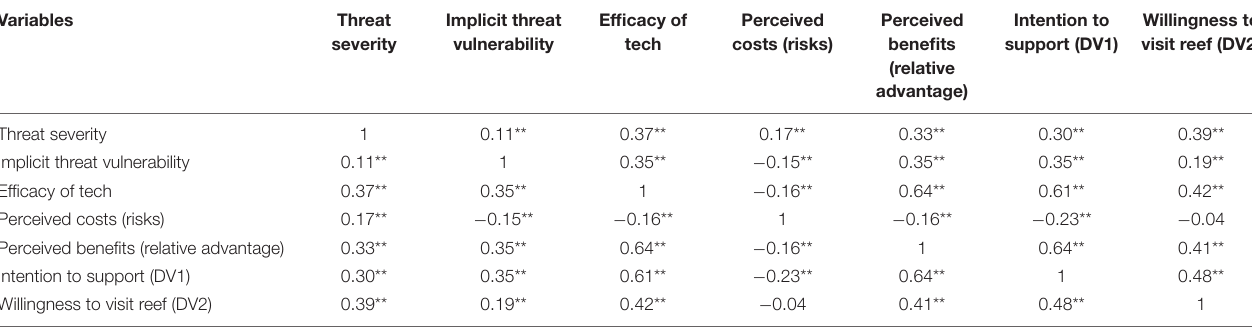
TABLE 2 | Correlation table showing the relationships between all independent and dependent variables in the study.